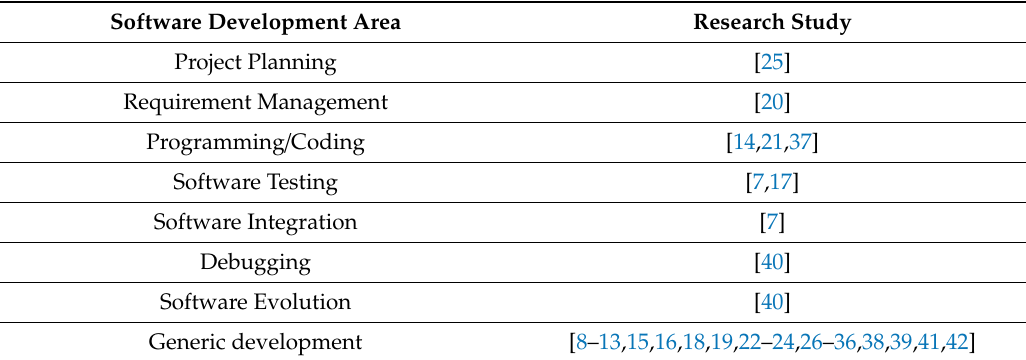
Table 5. Software Development Areas Focused by